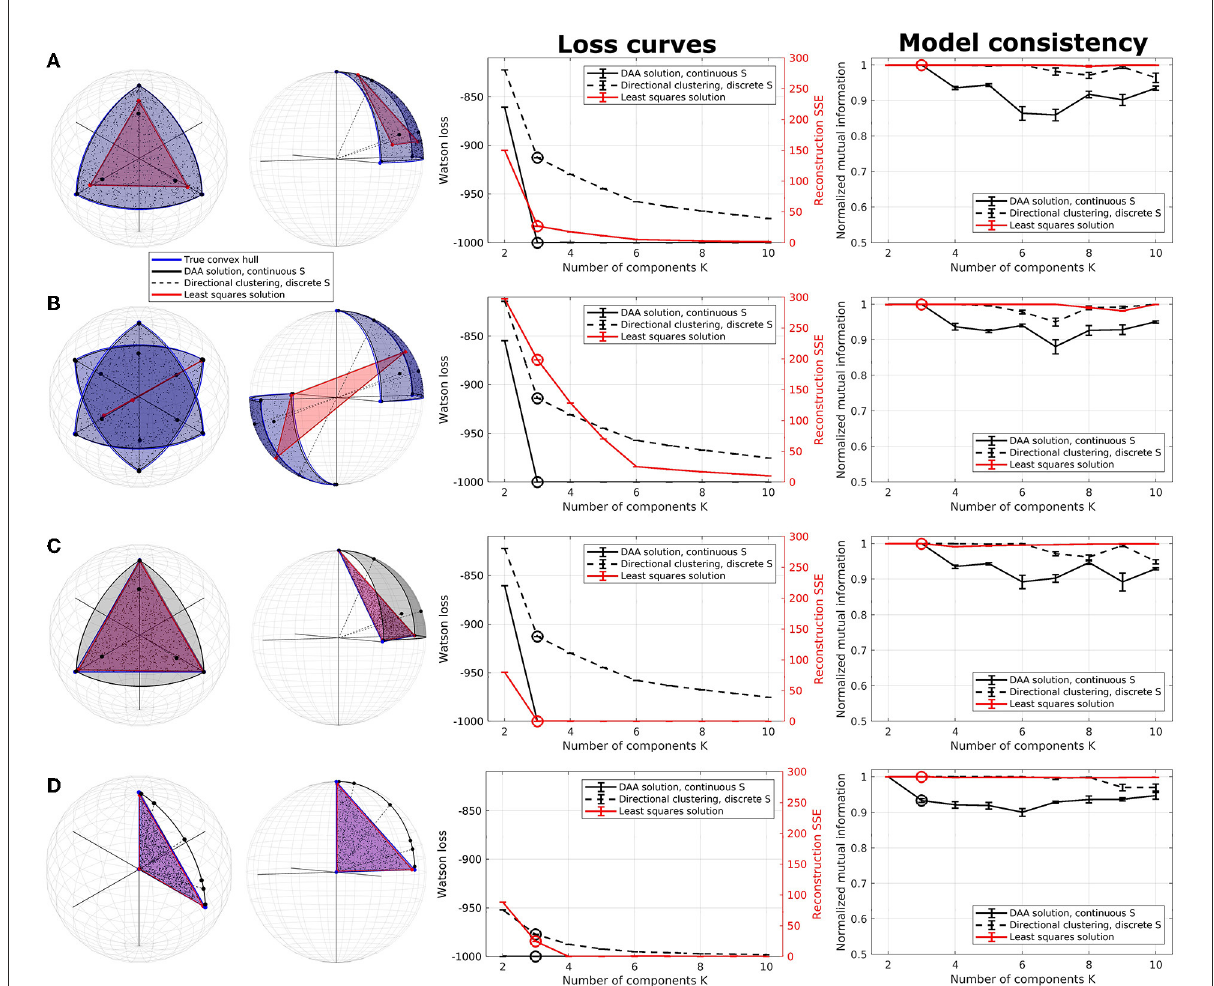
FIGURE1 Illustration of directional archetypal analysis (DAA) vs. its Euclidean counterpart and a directional clustering model in three dimensions, including loss curves and normalized mutual information (NMI), which are evaluated on 5 models each being the best of 100 simulations. (A) Spherical data simulated using three true archetypes situating on the axis corners. The solutions obtained using conventional Euclidean archetypal analysis and directional archetypal analysis with K 3 components and the convex hull spanned by the archetypes, as well as centroids = determined using directional clustering, are also shown. (B) Spherical data simulated with three true archetypes situating on the axis corners as well as their diametrical opposite, i.e., polarity-invariant archetypes. (C) Non-spherical data simulated using the same three true archetypes as in (A) . (D) Data simulated with three true archetypes, of which one is the origin. Error bars represent standard error of the mean. Note that the loss functions for the models (Watson loss and sum of squared errors, respectively) are not directly comparable but are shown on the same graph to highlight corners in the loss indicating a potential optimal